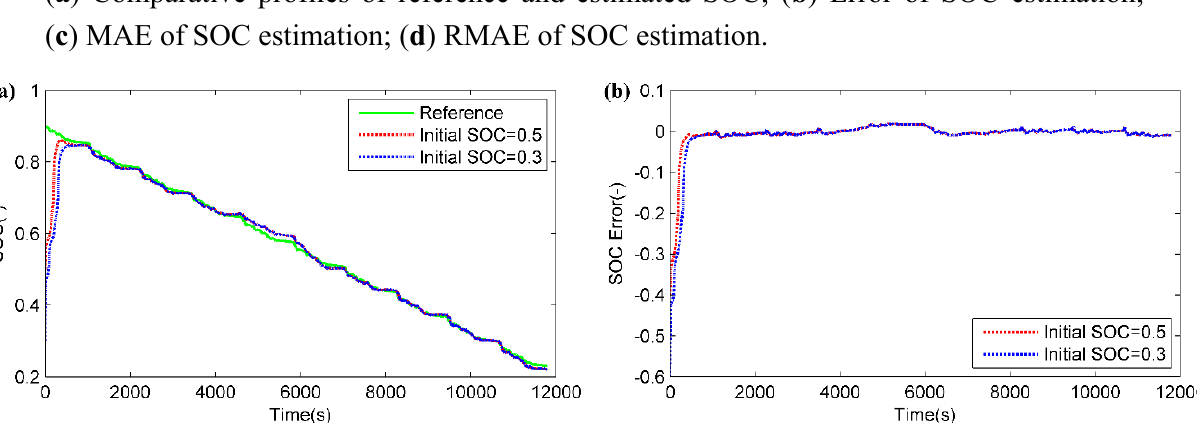
Figure 12. Estimation results with inaccurate initial SOC for LFP cell: ( a ) Comparative profiles of reference and estimated SOC; ( b ) Error of SOC